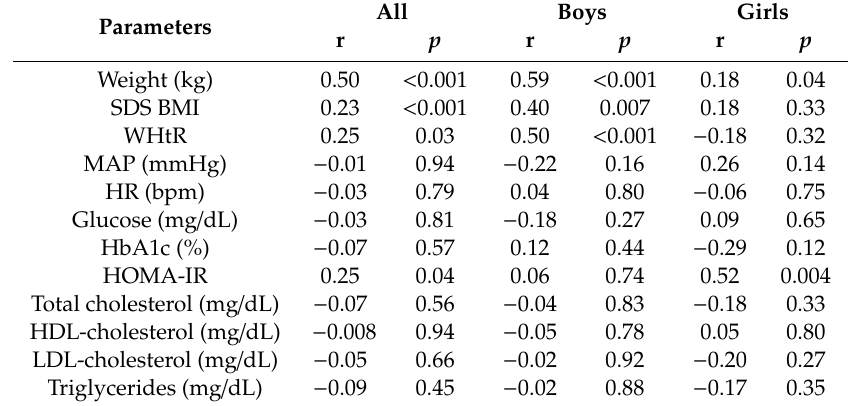
Table 2. Pearson correlation between carotid-femoral pulse wave velocity and clinical, anthropometric, and analytical